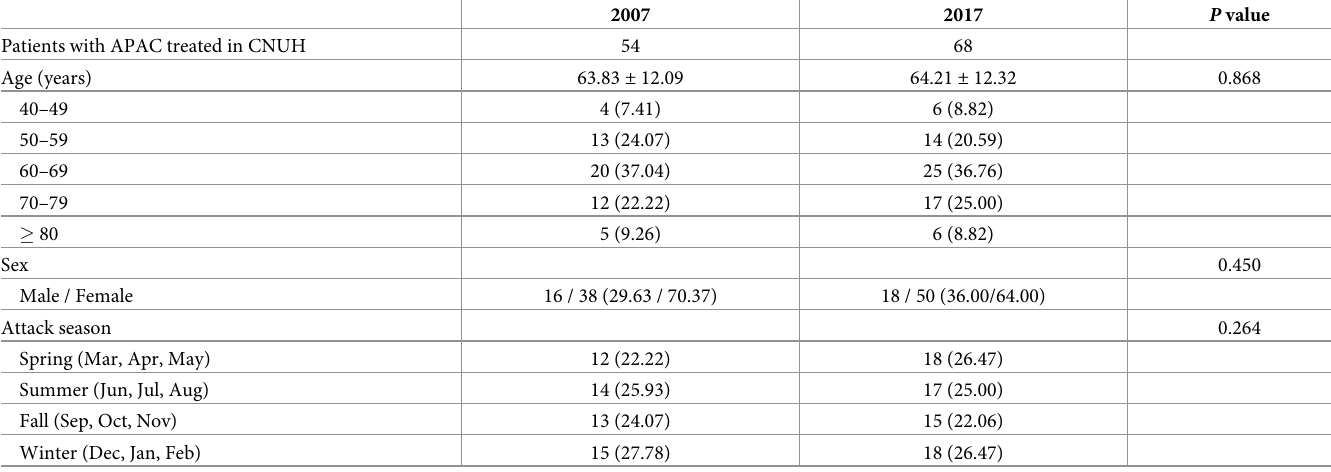
Table 2. Demographic characteristics of patients with acute primary angle closure in 2007 and